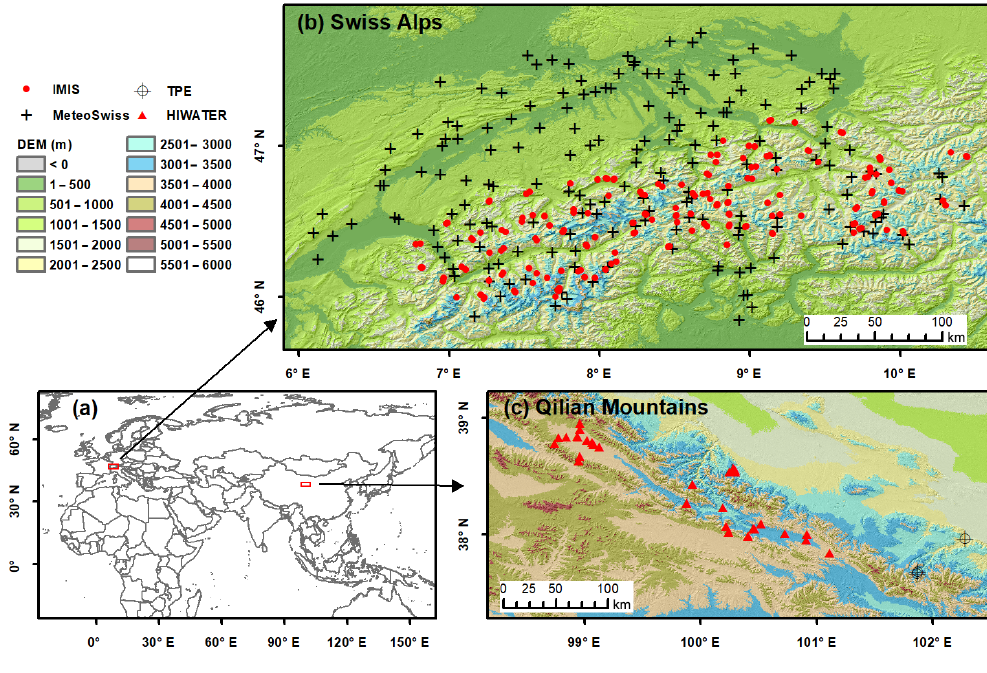
Figure 1. Location of experimental region (a) : observation stations in the Swiss Alps (b) and the Qilian Mountains (c) .